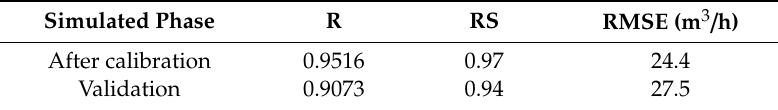
Figure 8. Correlation between the simulated and observed discharge, ( a ) Total inflow after calibration of the model (2012–2015); ( b ) Total inflow in the validation phase (2016). Table 3. The values of